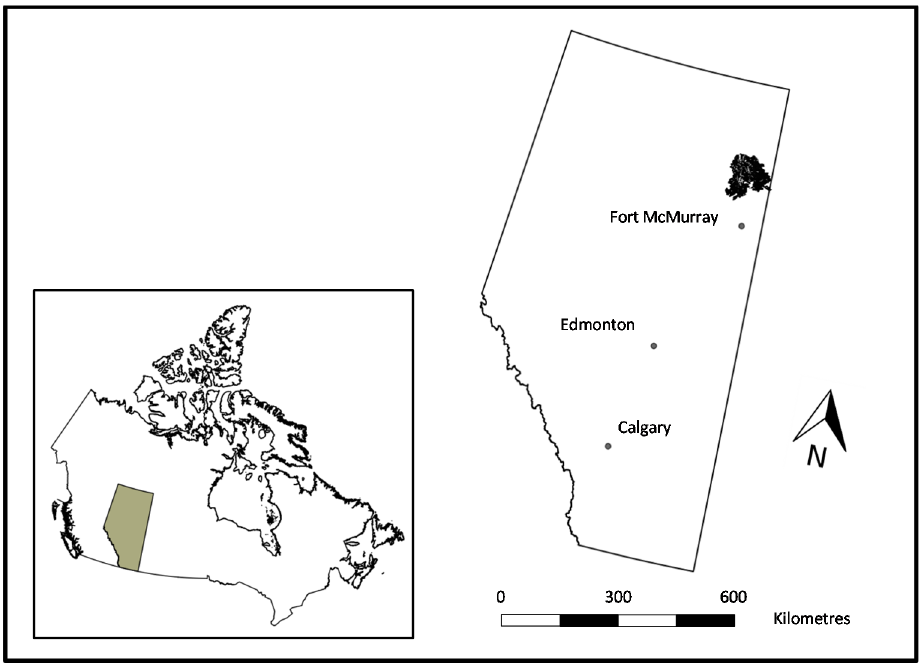
Figure 1. Location of the 2011 Richardson Fire in northeastern Alberta, Canada.